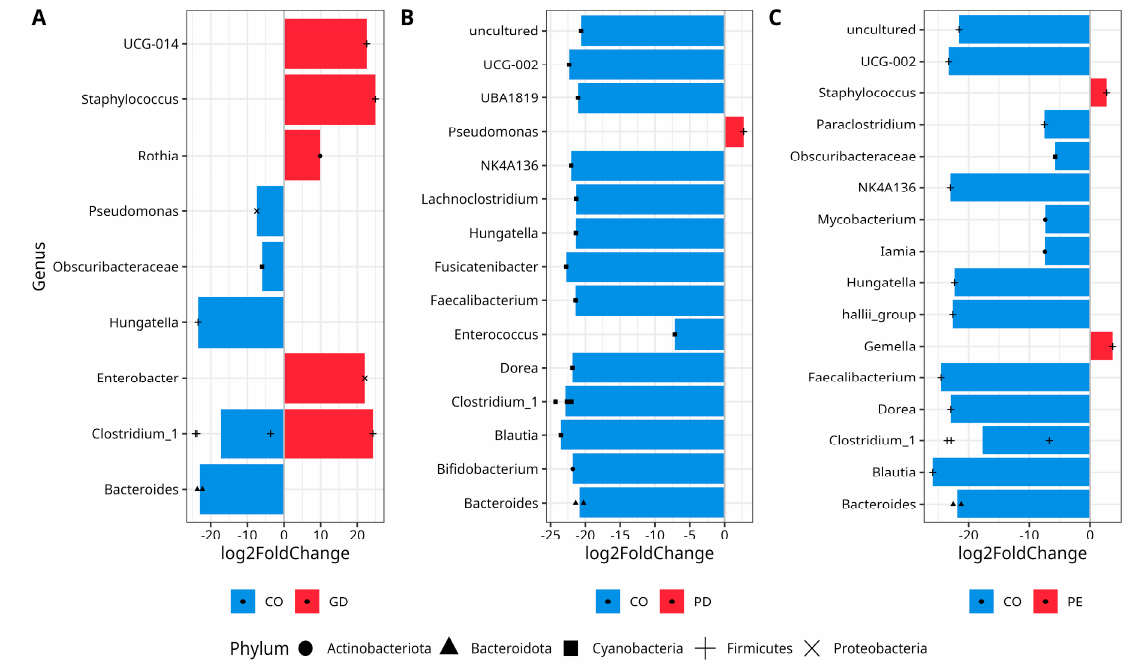
Figure 3. Differential abundance analysis of bacterial genera with DESeq2. The Figure shows data for ( A ) CO vs. GD, ( B ) CO vs. PD, and ( C ) CO vs. PE. Normalization was made with size factor from counts geometric means and the Wald test was applied to calculate differences between groups, False Discovery Rate (FDR) was used to correct p -values. Log2 Fold Change is shown by the horizontal bars. Bacterial taxa with q values <0.05 are written alongside the Y-axis. Phyla are shown with a black solid circle (Actinobacteriota), black solid triangle (Bacteroidota), black solid square (Cyanobacteria), plus symbol (Firmicutes), and cross symbol (Proteobacteria) at the bottom. The repetition of symbols indicates that more than one ASV was reported in the analyses. UCG-014 (Class Clostridia), Clostridium_1 ( Clostridium_sensu_stricto_1 ), uncultured (Oscillospiraceae), UCG-002 (Oscillospiraceae), UBA1819 (Oscillospiraceae), NK4A136 (Lachnospiraceae), halli_group (Eubacterium). —(see Supplementary Materials for full taxon description, log2FoldChange, p , and p-adjusted values for CO versus GD, Table S9; CO versus PDF, Table S10, and CO versus PE, Table